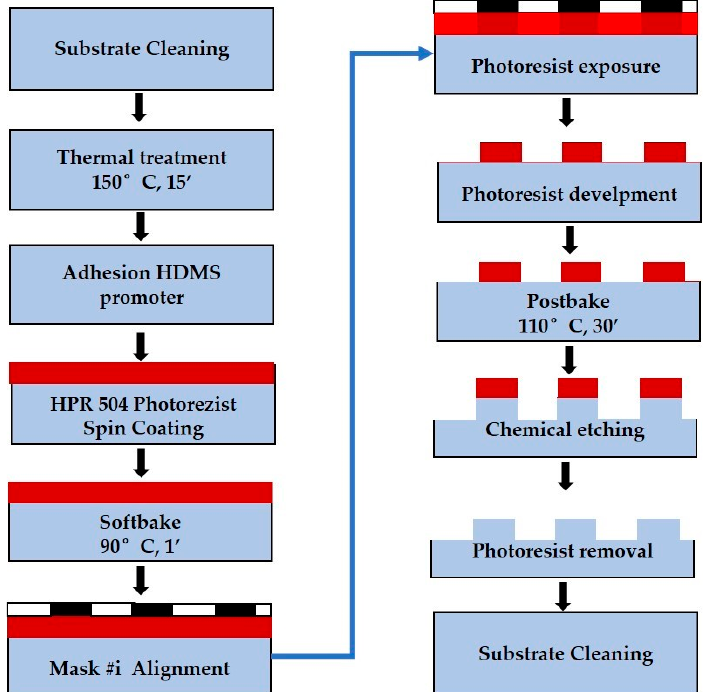
Figure 7. Flow chart for the fabrication of multilevel axicon with a number of #i photolithographic masks.